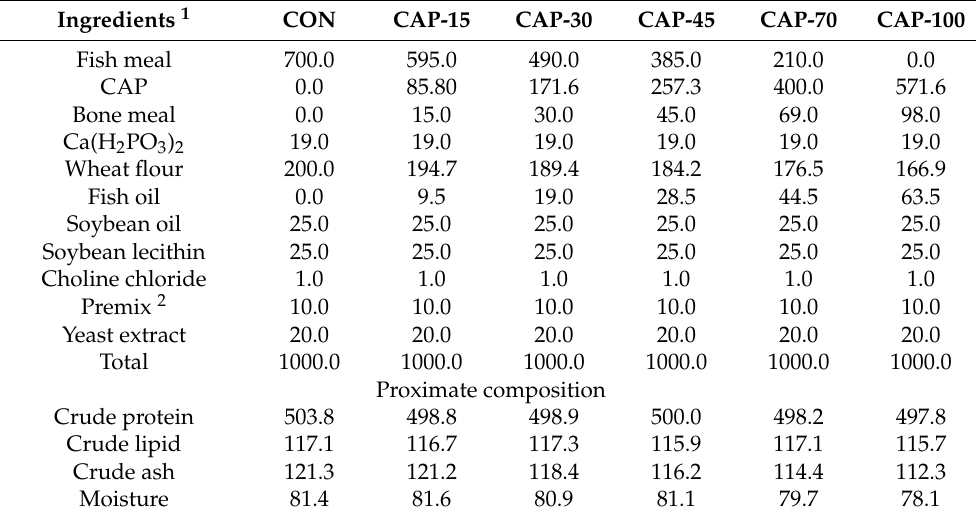
Table 1. Formulation and proximate composition of experimental diets (g/kg).